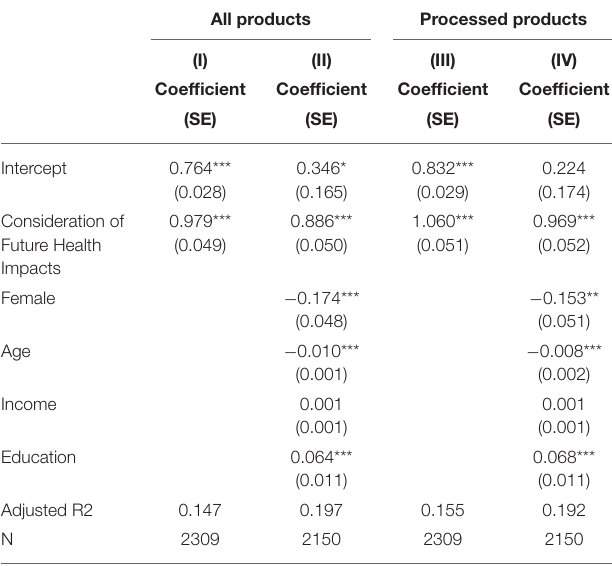
TABLE 5 | Adjusted odds ratios (aOR) and 95% confidence intervals (95%CI) from logistic regression of fiber prompt message on consideration of future health impacts of foods during food